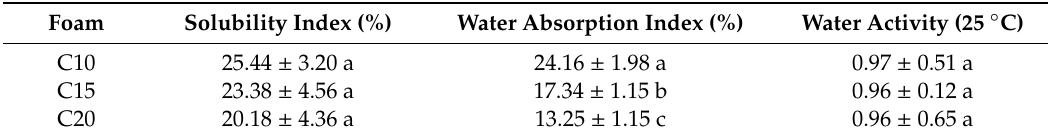
Table 1. Solubility index, water absorption index, and water activity of foams based on potato by-products. Foam Solubility Index (%) Water Absorption Index